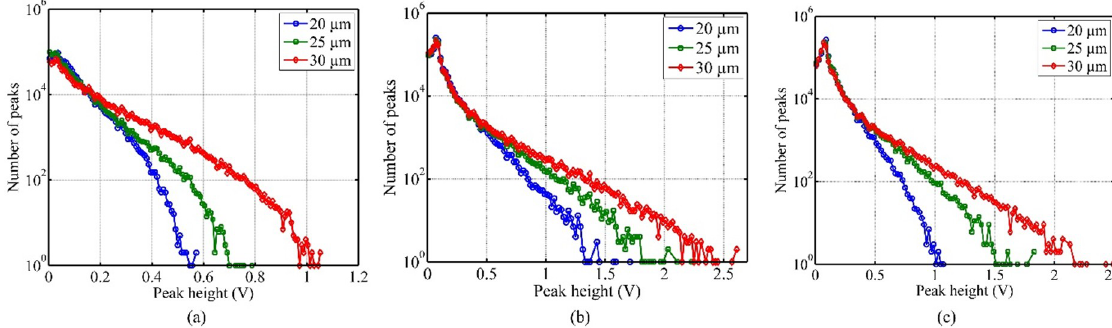
Figure 3. Load peak distribution of at the standoff distances of ( a ) 0.2 mm, ( b ) 0.6 mm and ( c ) 1.0